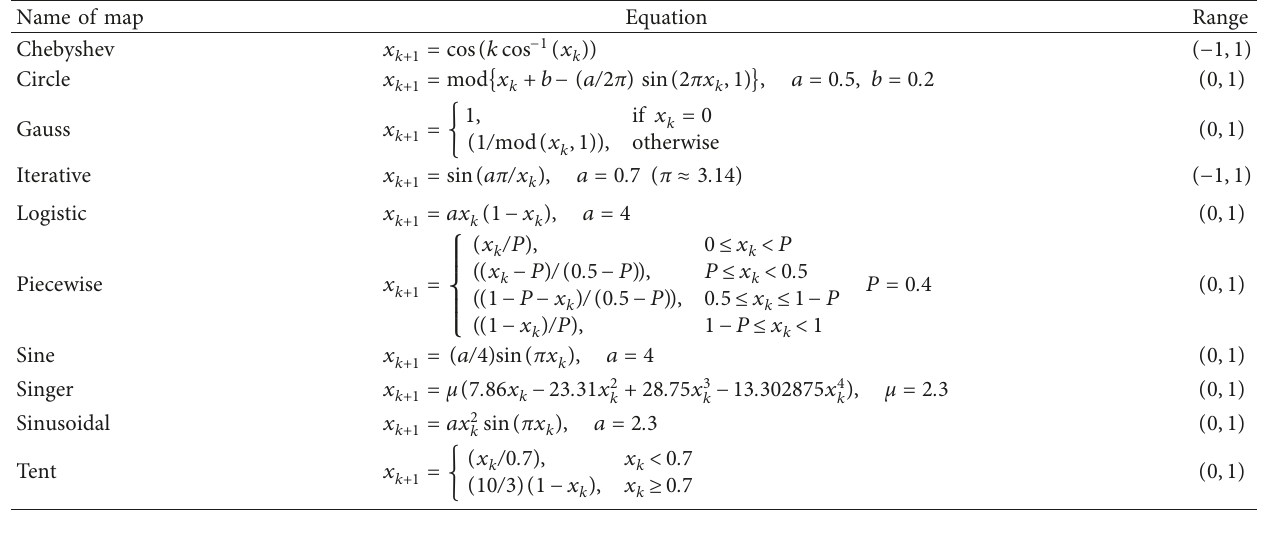
Table 1: Definition of chaotic maps [28].